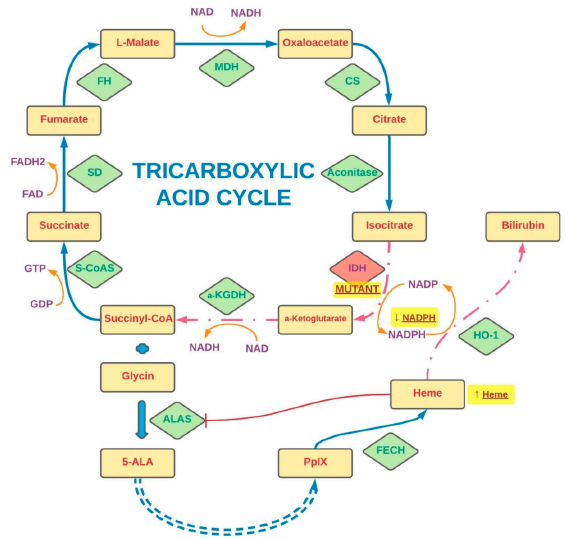
Figure 2. The stages of the tricarboxylic acid cycle and the effects of IDH mutations on protopor- phyrin IX metabolism. The synthesis steps are indicated by solid arrows, and the regulatory steps by dashed arrows. The shortened conversions are marked by a double-dashed arrow. A red indi- cator (T) points to a transformation inhibited by another factor. The effects of IDH mutations are highlighted by a yellow glow. S-CoAS—Succinyl-CoA synthetase, SD—succinate